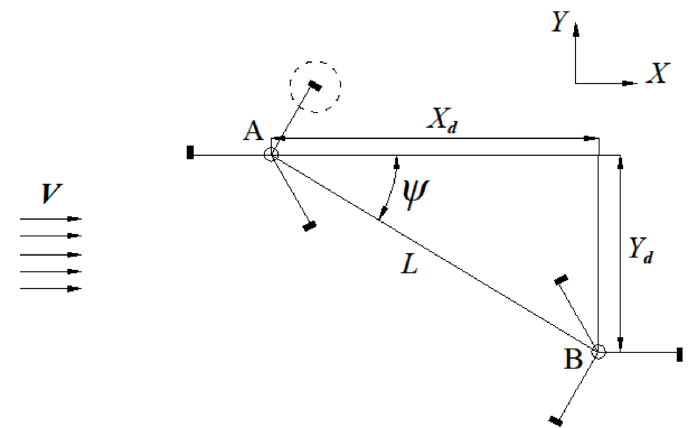
Figure 4. Turbine layout diagram [79].